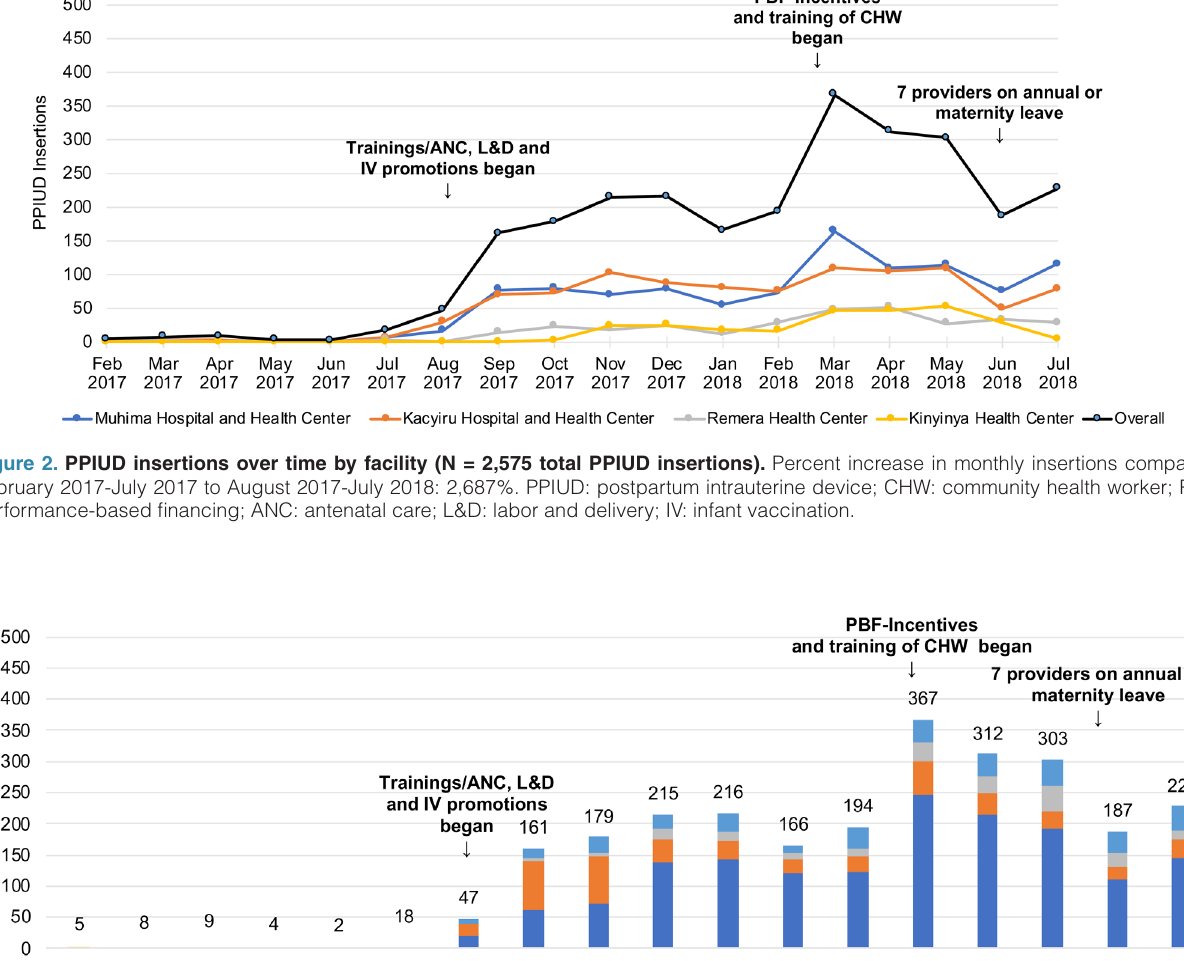
number of insertions per month. We used descriptive